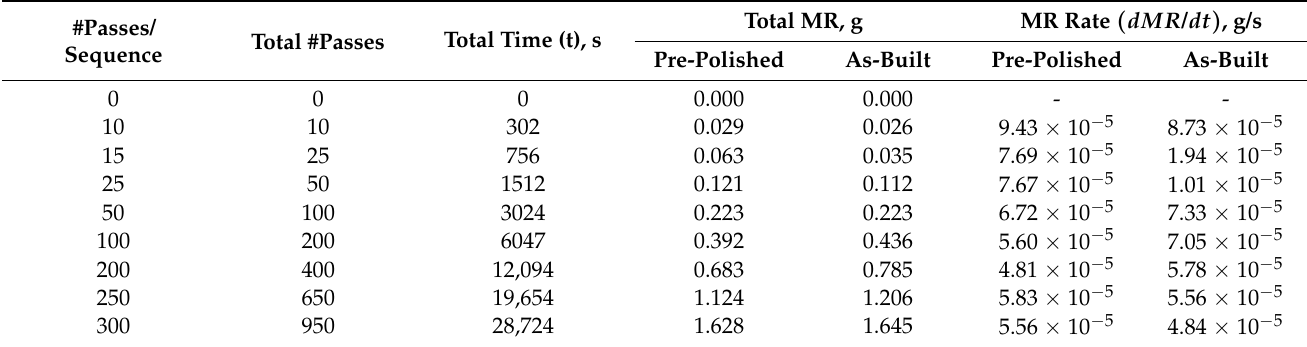
Table A1. MR weight measurements, V-Shape: Pre-Polished/As-Built.